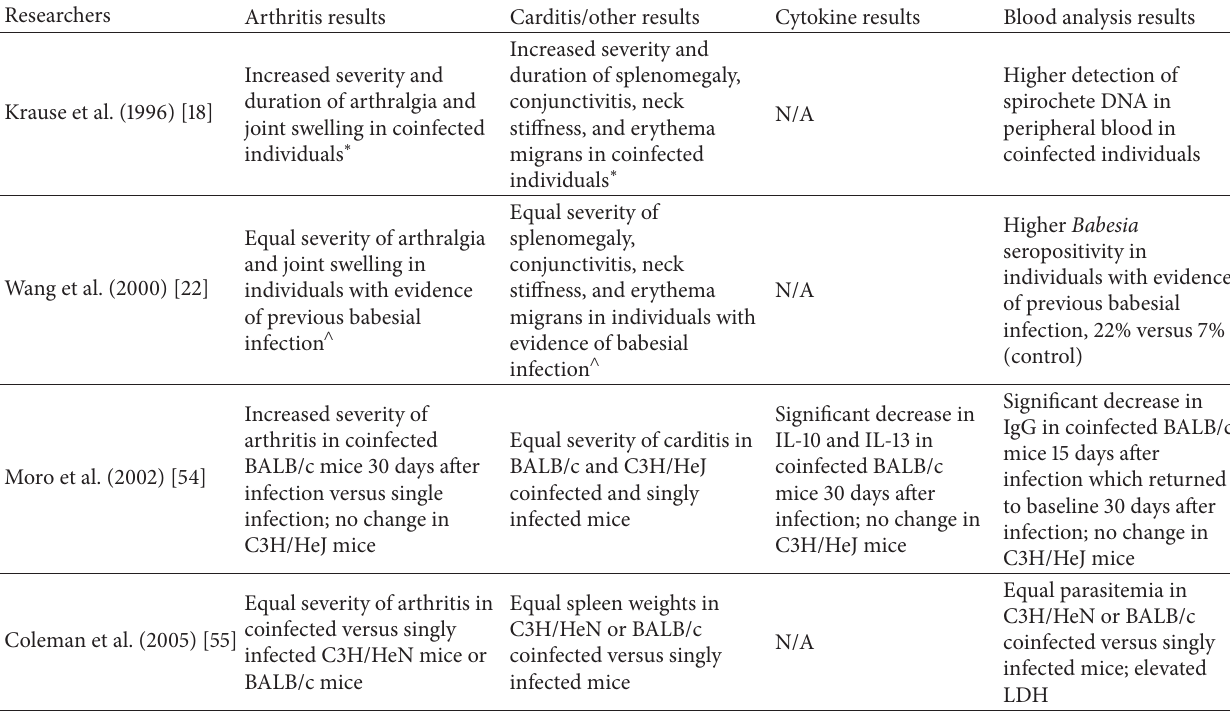
Table 1: Summary of results from four key studies investigating the impact of B. burgdorferi and B. microti coinfection.